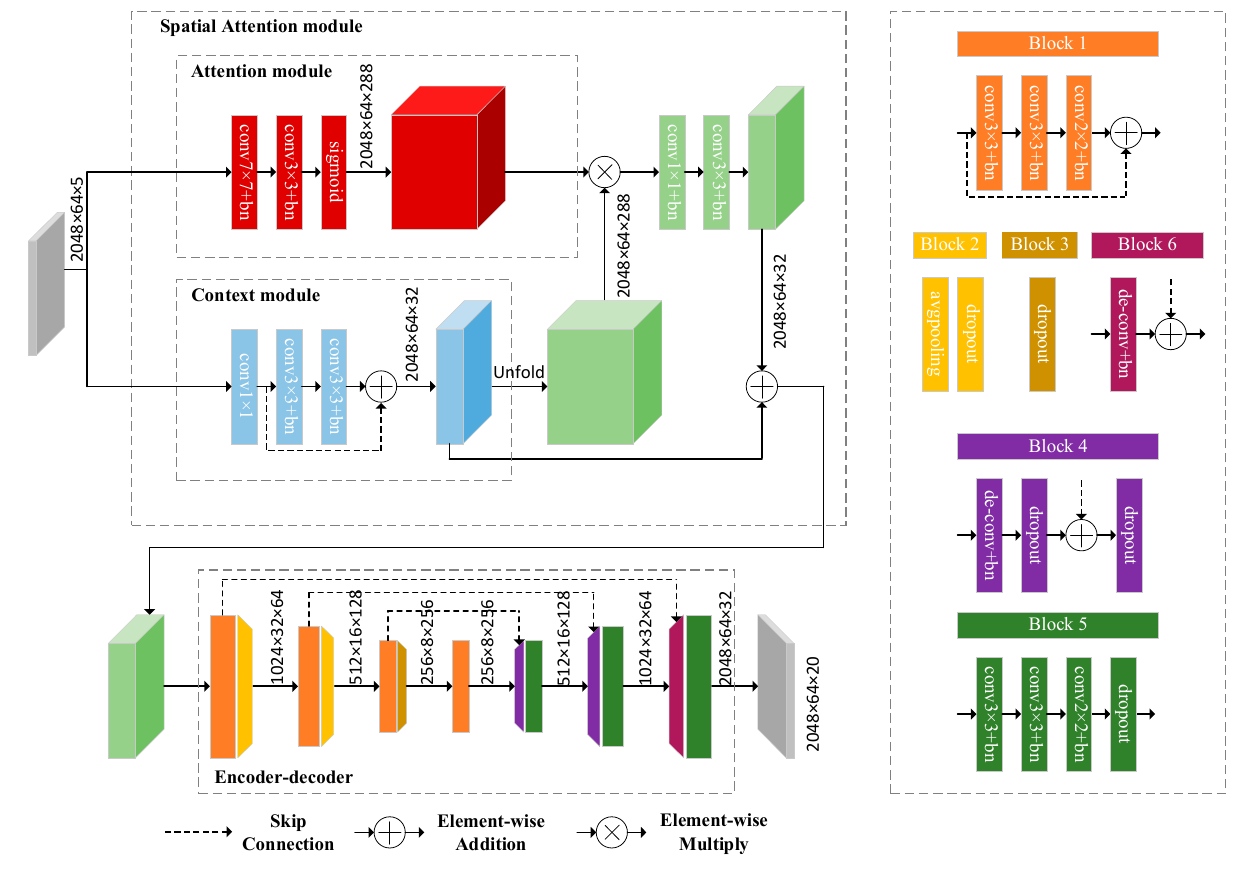
Figure 5. Architecture of the proposed SANet.